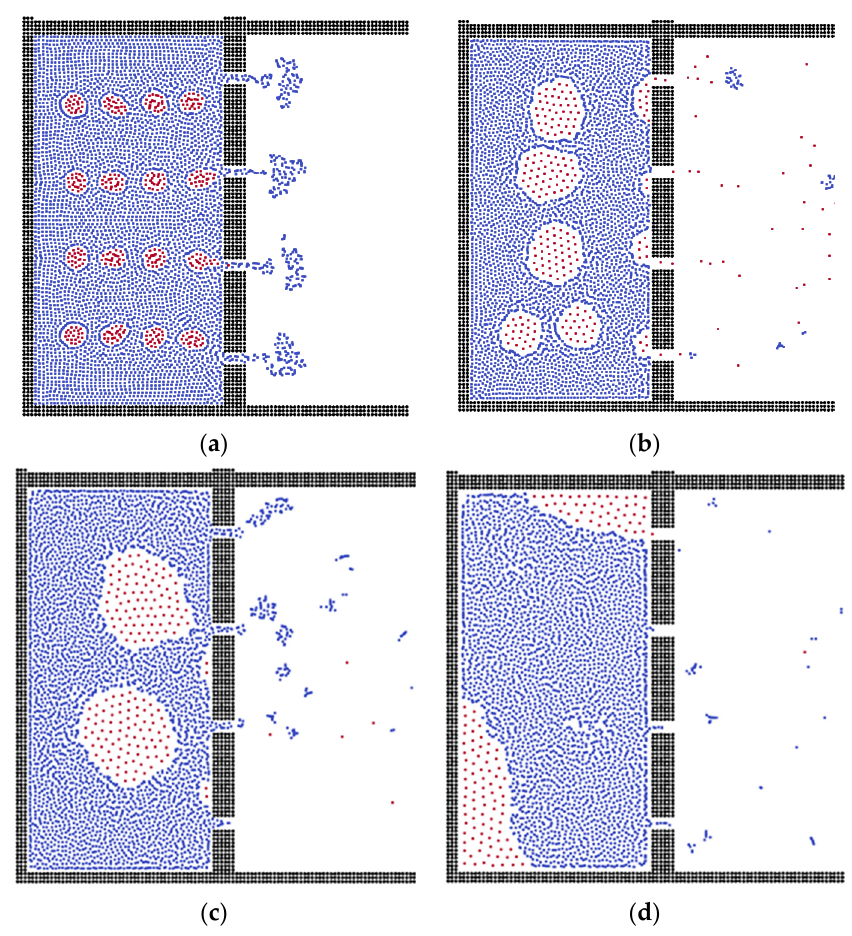
Figure 2. The separation processes during different time steps. ( a ) Step = 5, ( b ) Step = 20, ( c ) Step = 100, ( d ) Step =